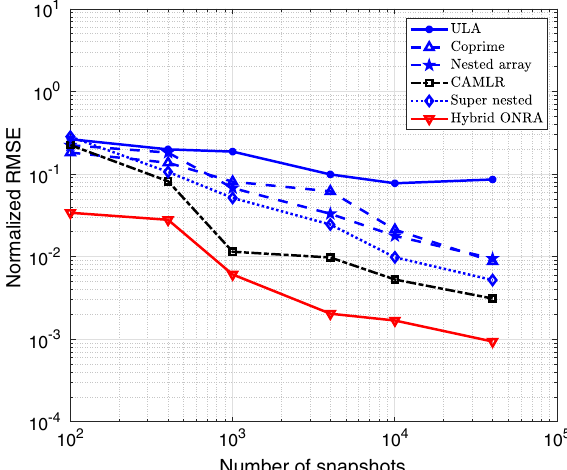
Fig. 5 RMSE of the CU-RIS channel versus the number of snapshots when the paths are well separated (transmit